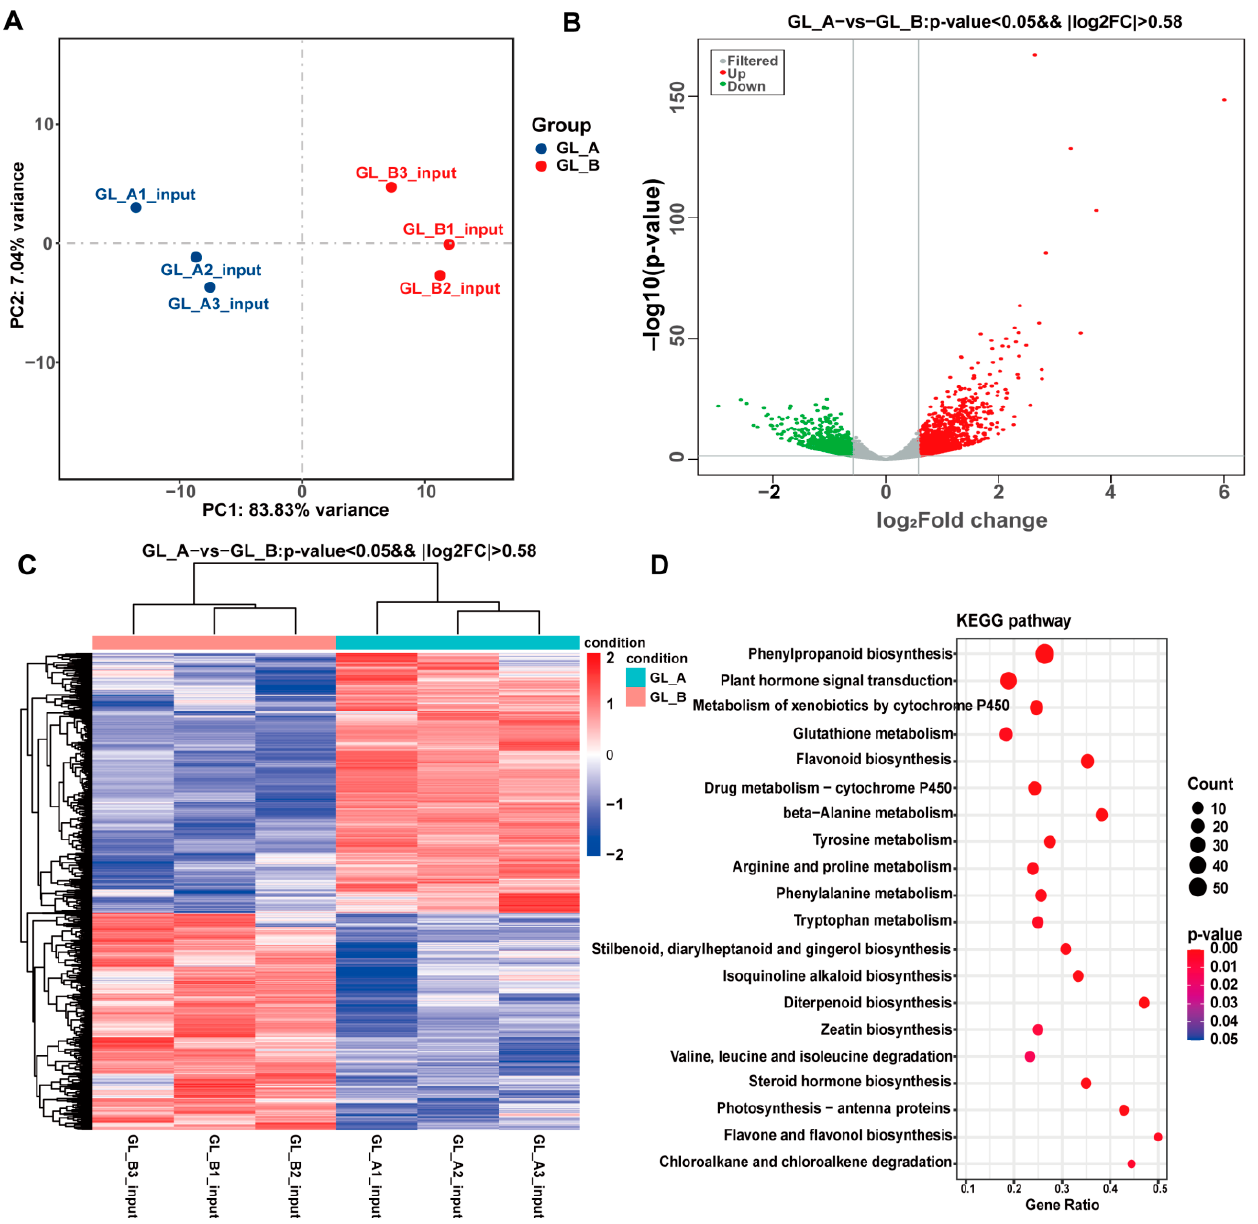
Figure 9. Analysis of differential expression, based on RNA-Seq data, between the analyzed leaves. ( A ) Principal component analysis (PCA) of Sorghum between the GA 3 -treated (GL_A, n = 3) and control (GL_B, n = 3) leaves. ( B ) Volcano plots depicting the differential gene expression between the examined leaves. ( C ) Heatmap plot of all DEGs. ( D ) KEGG network enrichment analyses of all DEGs.